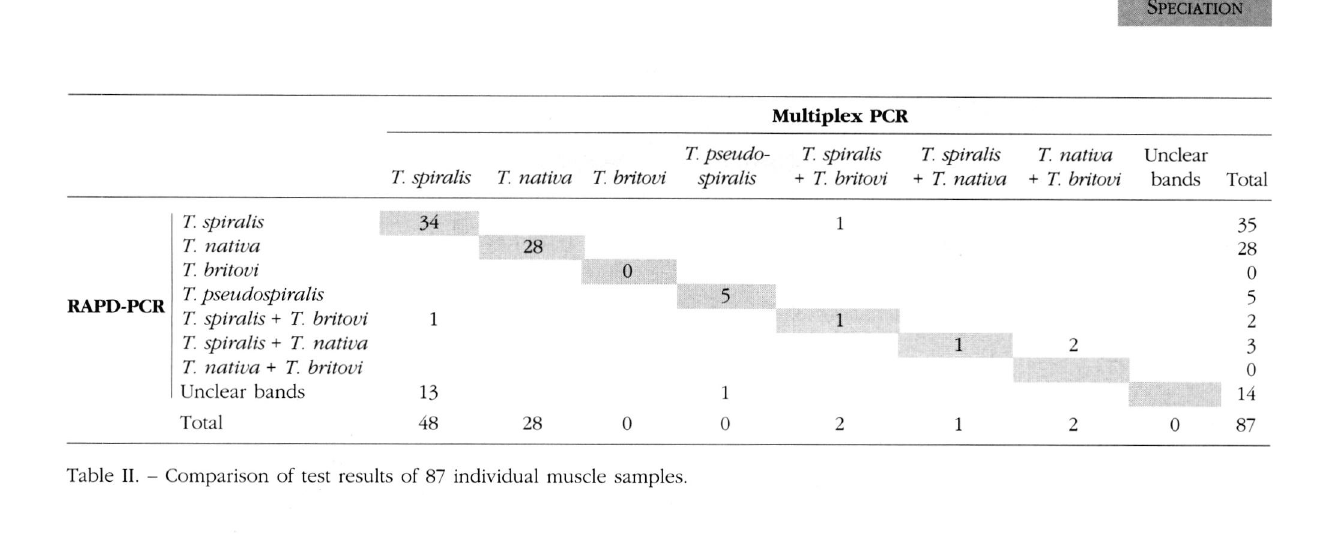
similarity to the reference strains were easy to inter pret (Fig. 2). Highest discrepancy between the methods were often found in the differentiation of T.